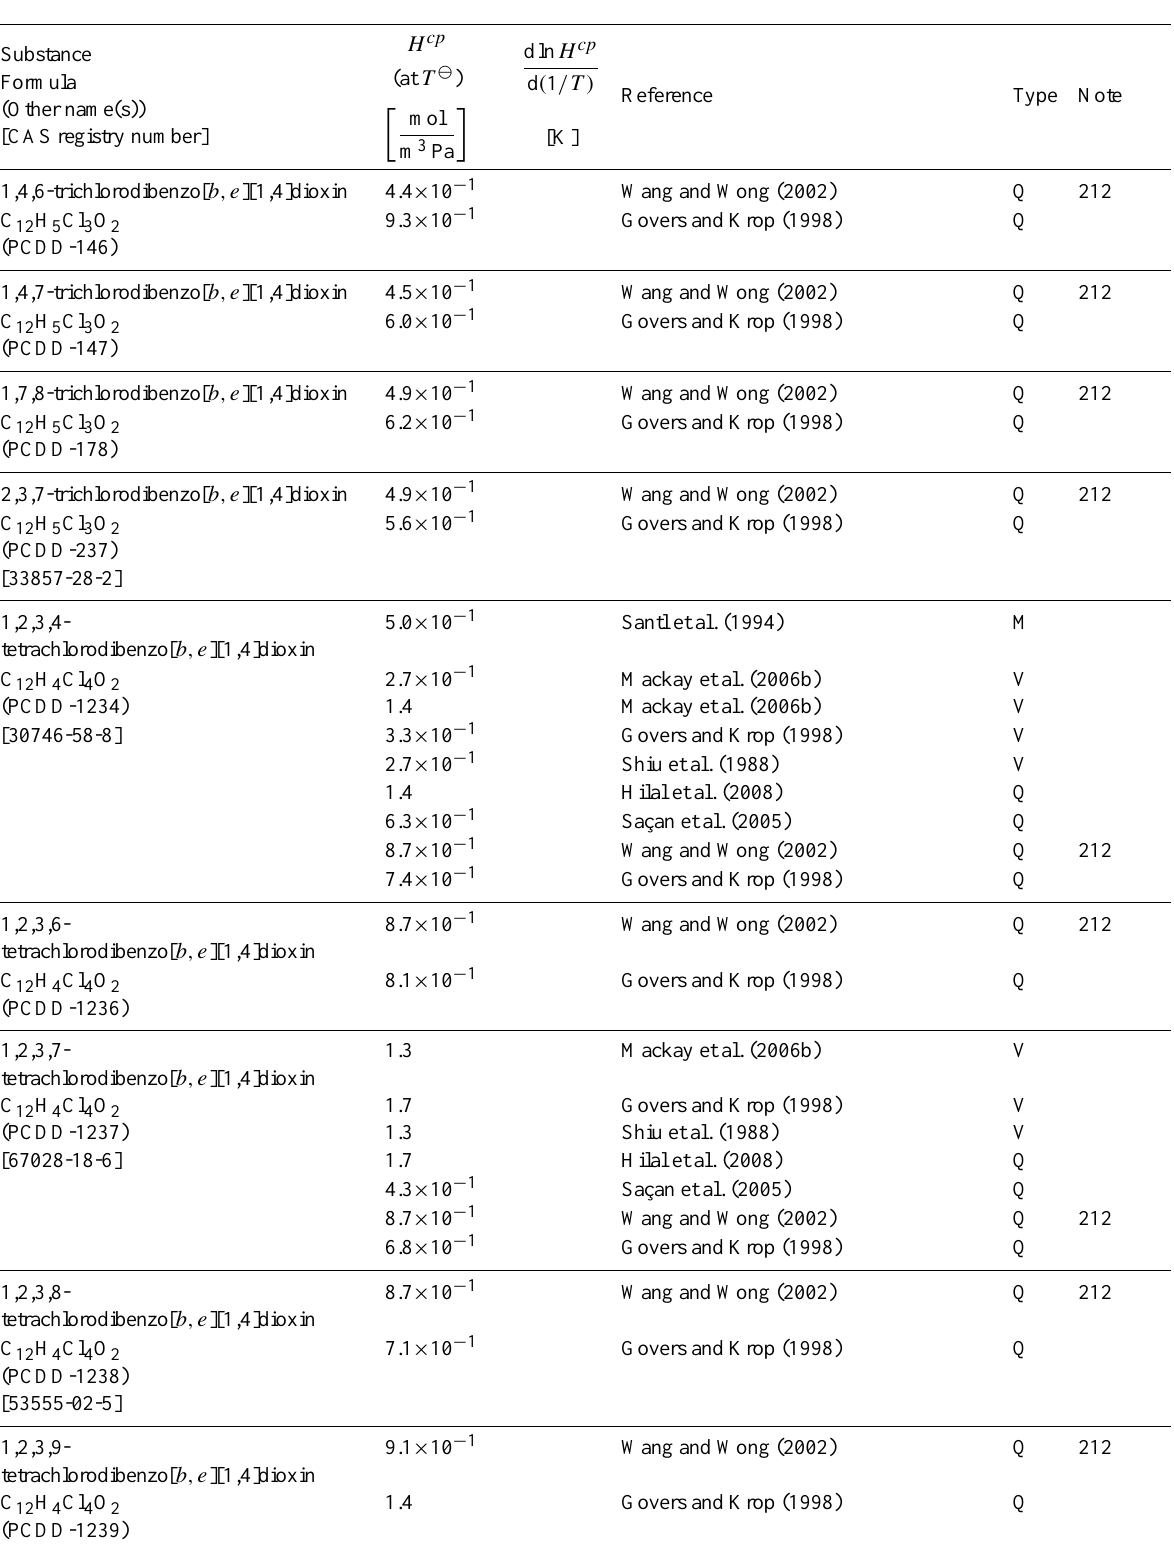
Table 6: Henry’s law constants for water as solvent